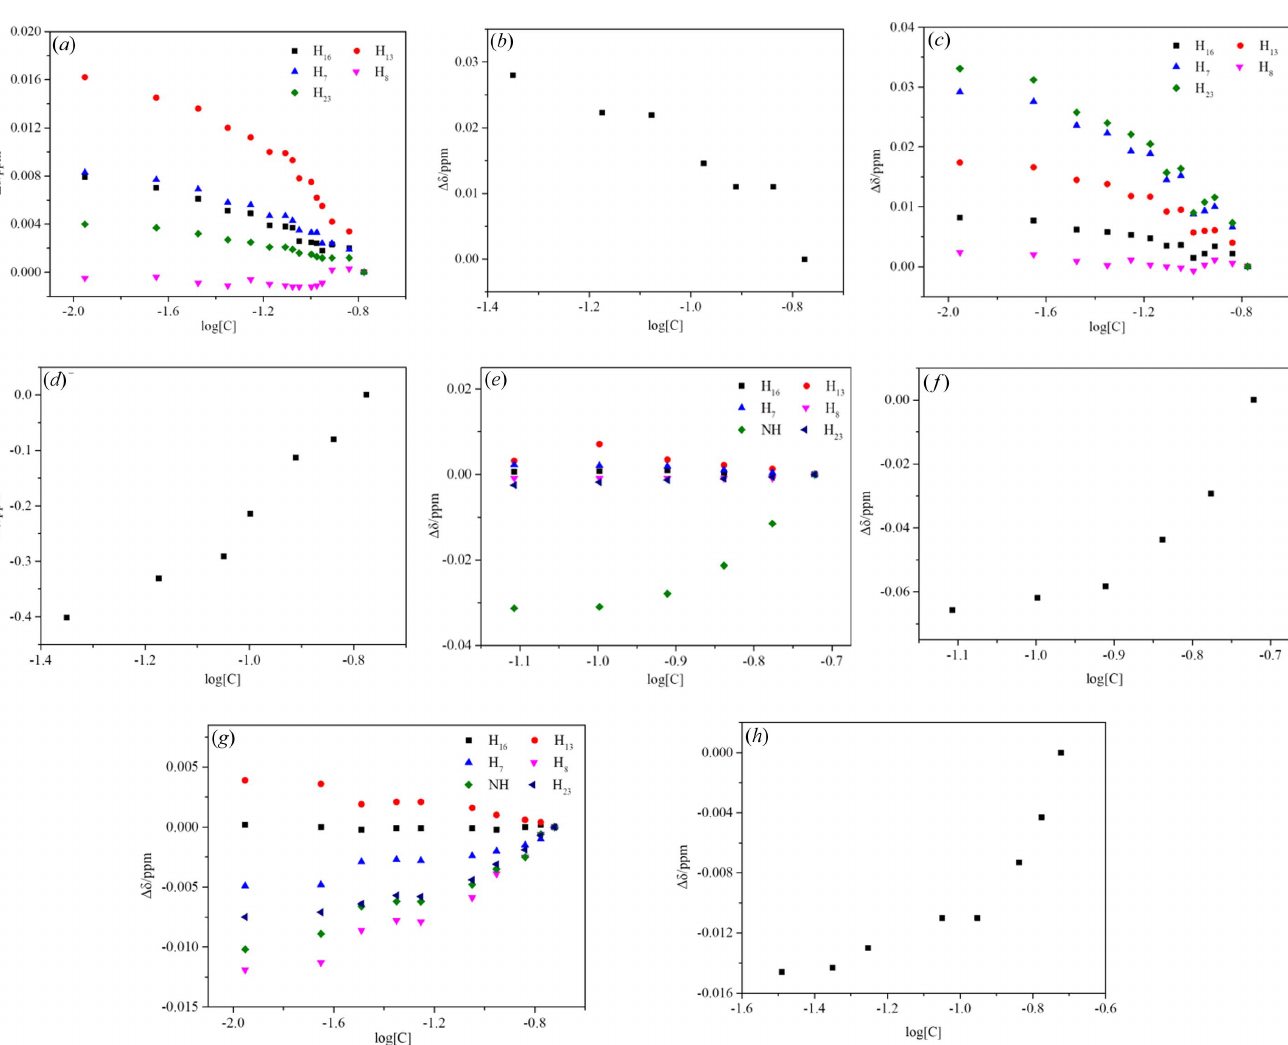
Figure 8 Chemical shifts of 1 H and 13 C on the carboxyl group change with concentration at room temperature. ( a ) and ( b ) PHEN in methanol- d 4 , ( c ) and ( d ) PHEN in chloroform- d , ( e ) and ( f ) PHEN in acetonitrile- d 3 , ( g ) and ( h ) PHEN in DMSO- d 6